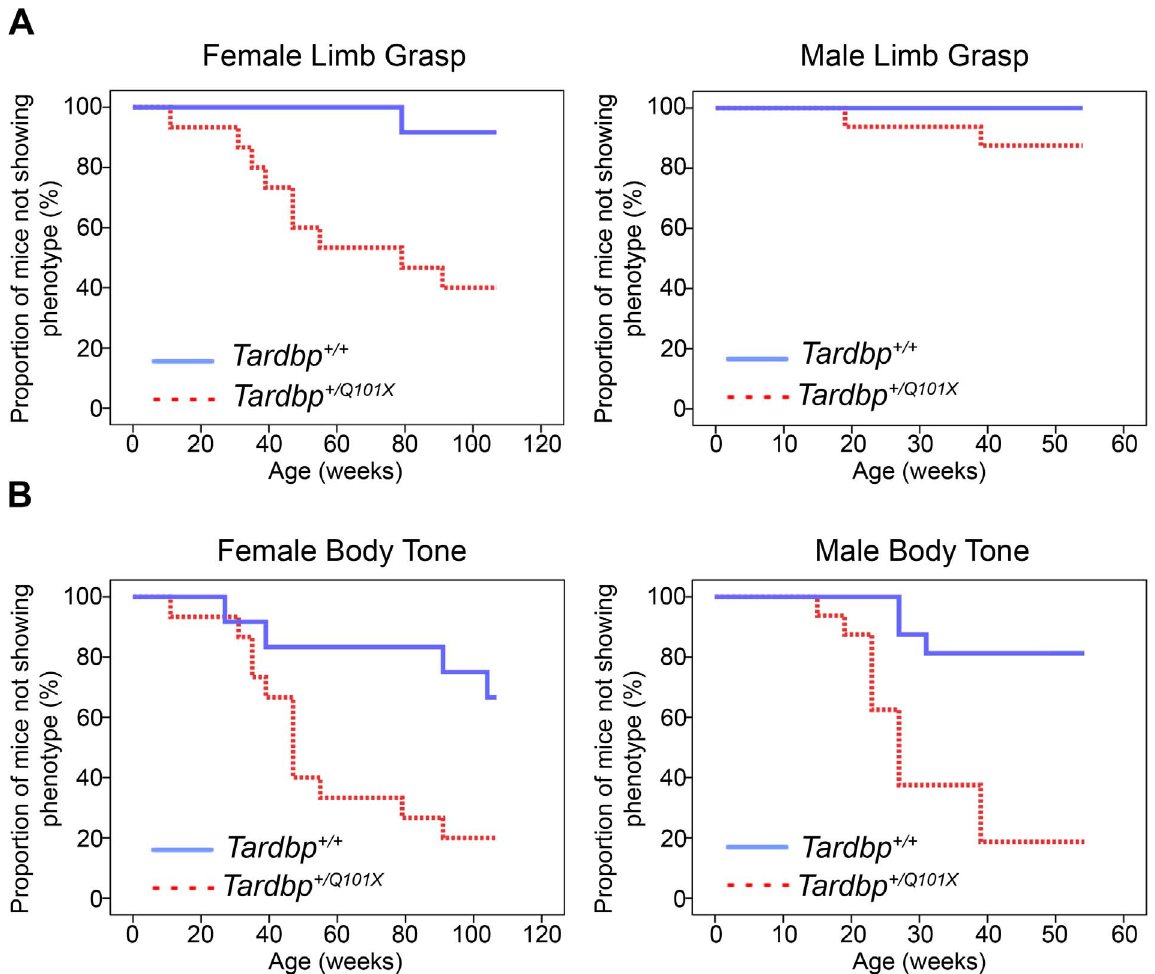
Figure 4. Limb-clasping and body tone abnormalities in Tardbp + /Q101X mice. ( A ) Tardbp + /Q101X mice develop hindlimb clasping. Plots show onset of hindlimb-clasping. The Y-axis is percentage of mice not showing the phenotype. At 7 weeks of age no mice showed limb clasping. Female mice (left panel): Tardbp + / + n=12, Tardbp + /Q101X n=15; Male mice (right panel): Tardbp + / + n=16, Tardbp + /Q101X n=16. Overall difference between Tardbp + / + and Tardbp + /Q101X p=0.002 (Kaplan Meier log rank statistic), with a significant difference also noted between male and female Tardbp + /Q101X mice up to one year (p=0.046). ( B ) Progressive development of abnormal body tone in male and female Tardbp + /Q101X mice. No mice displayed softer, abnormal body tone at 7 weeks of age. Male mice: Tardbp + / + n=16, Tardbp + /Q101X n=16. Female mice Tardbp + / + n=12, Tardbp + /Q101X n=15. Tardbp + / + versus Tardbp + /Q101X p , 0.0001 (Kaplan Meier log rank statistic), with a trend in sex differences of Tardbp + /Q101X genotype up to one year of age, p=0.07 (Kaplan Meier log rank